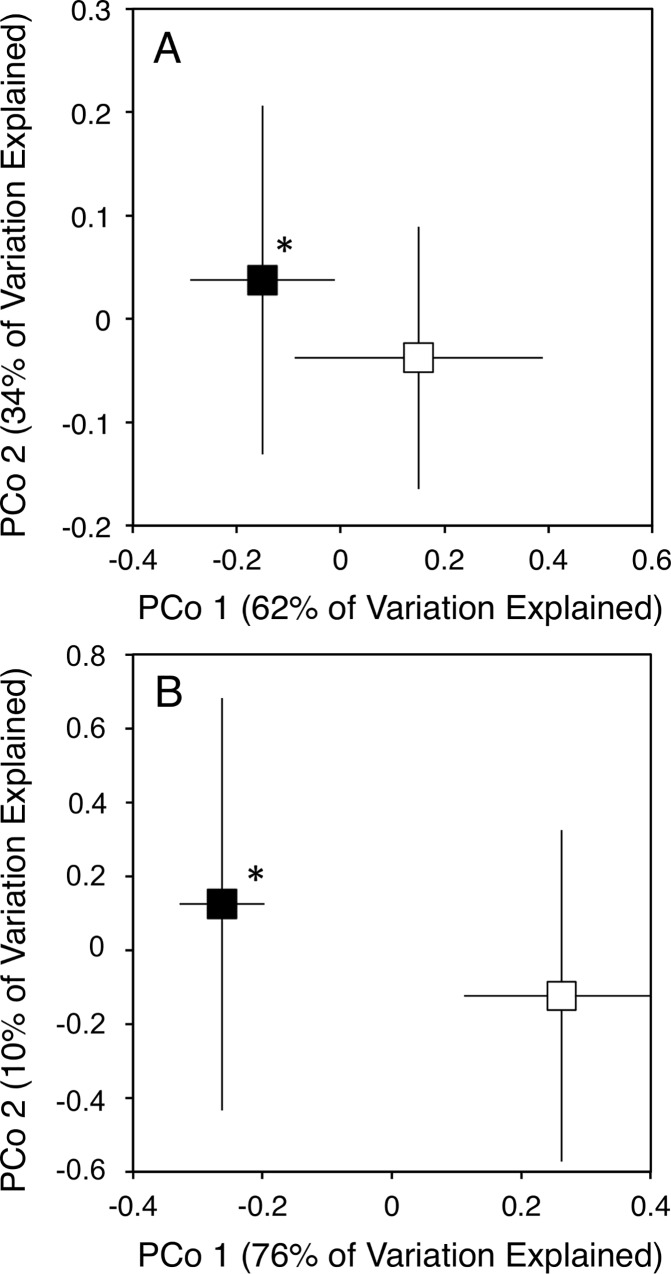
The effect of experimental N deposition on the composition of functional genes (A) and Subsystems gene pathways (B) associated with the N cycle. Ordinations were obtained from Principle Coordinates Analysis on based Euclidian distances of normalized data. Open and closed boxes indicate the composition of functional gene pathways in the ambient and experimental N deposition treatment, respectively. * P < 0.05 by PerMANOVA.